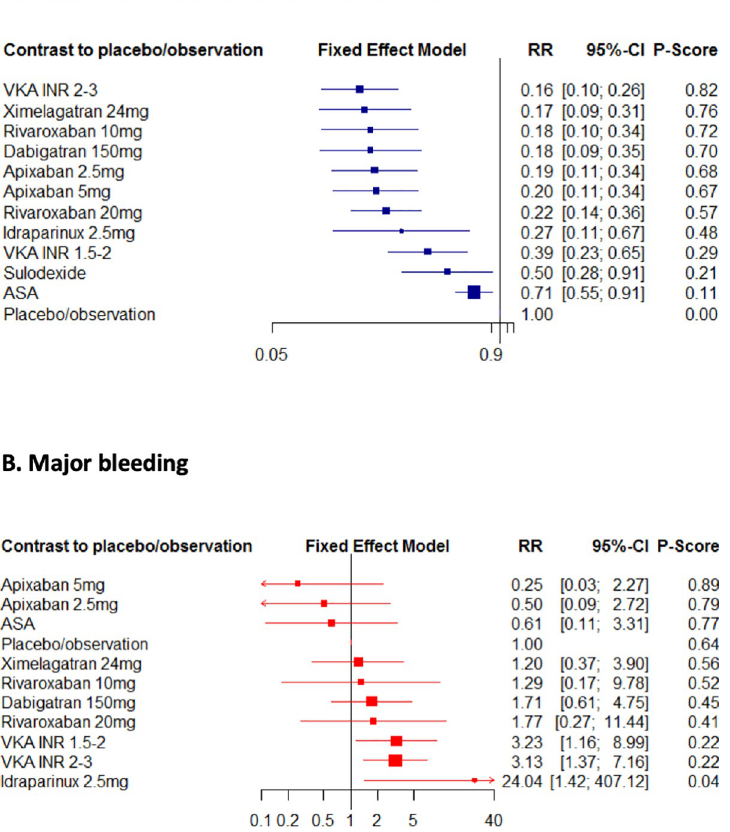
Fig 3. Relative risks (95% confidence interval) for (A) recurrent venous thromboembolic events and (B) major bleeding in network meta-analysis versus observation or placebo. ASA: aspirin; INR: international normalized ratio; VKA: vitamin k